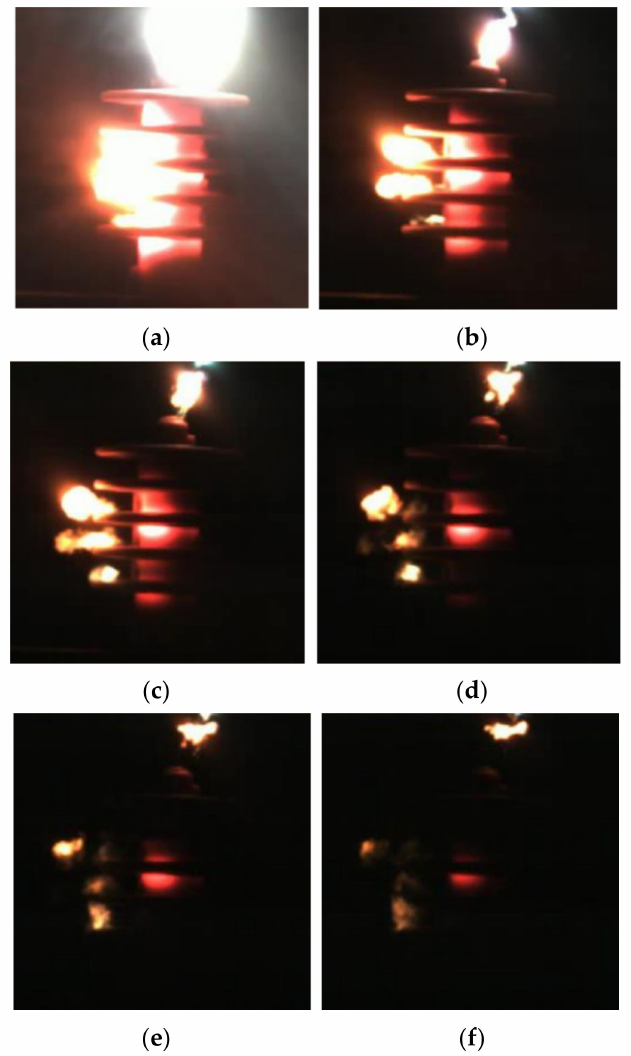
Figure 12. Recorded arc-quenching images by high-speed camera. ( a ) t = 0.01 ms; ( b ) t = 0.05 ms; ( c ) t = 0.1 ms; ( d ) t = 0.15 ms; ( e ) t = 0.2 ms; ( f ) t = 0.35 ms. The arc voltage waveform is recorded by an oscilloscope in Figure 13. As shown in the figure, the arc voltage drops to zero at t = 0.05 ms, which is the effective time to extinguish the arc. Subsequently, the arc voltage reaches to a certain value, which is less than the initial arc voltage. This process is accompanied by the recombination of positive and negative ions, which indicates that the energy of the arc is extremely